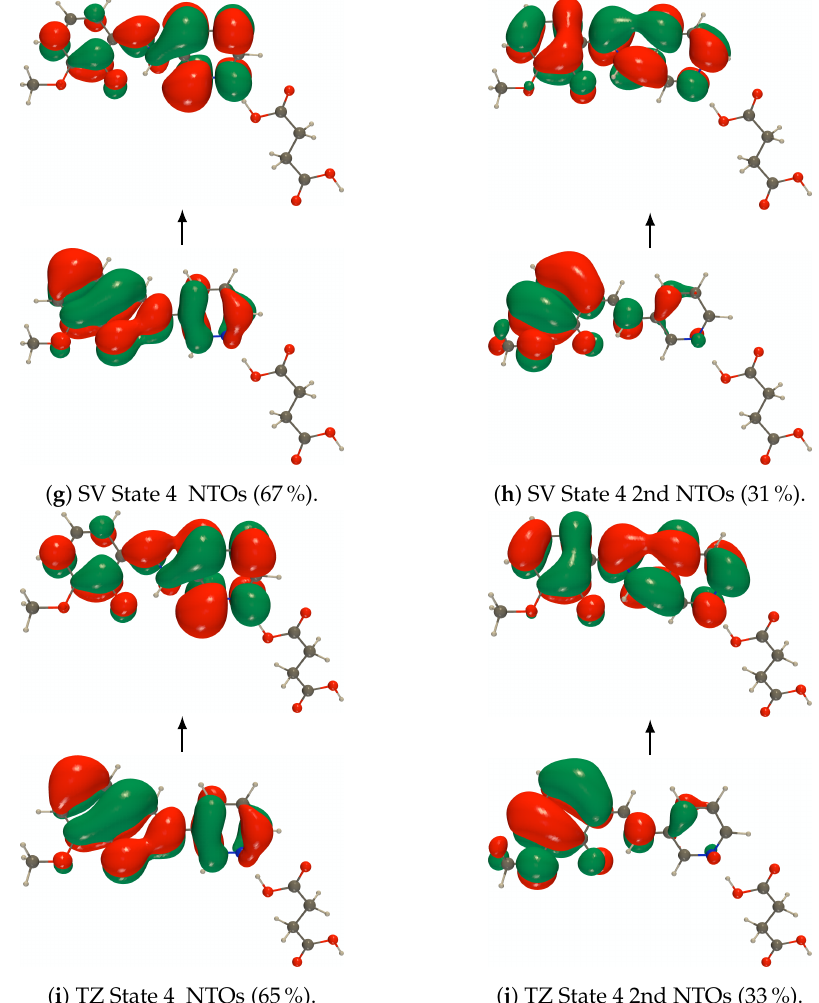
Figure A8. RI-CC2 def2-SVPD (SV) and def2-TZVPD (TZ) NTOs (holes below the arrows and particles above them, the red (green) lobes are the positive (negative) ones) of the embedded PYV3 + SA [PYV3 · SA] keto form (isovalue of